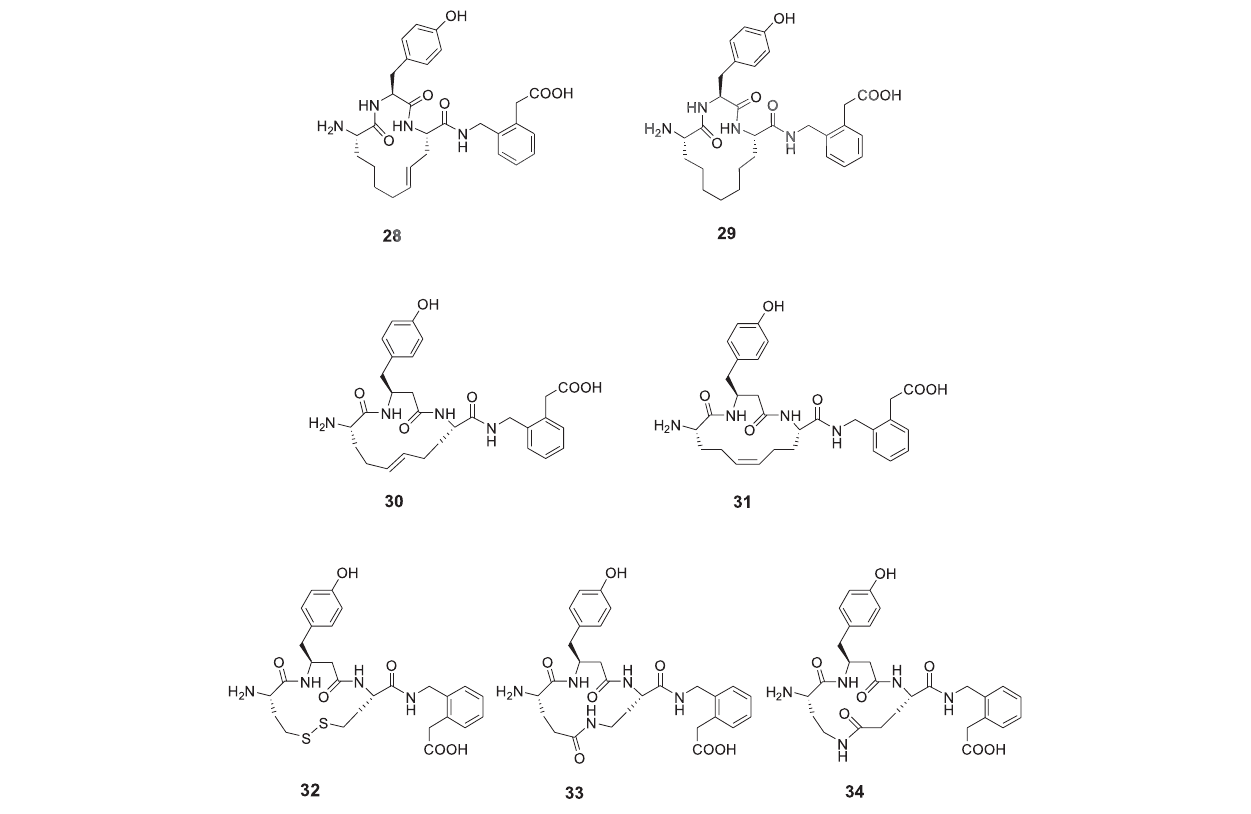
Frontiers in Pharmacology |